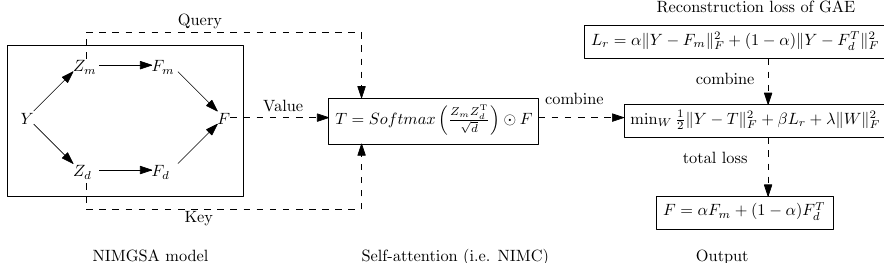
Figure 3. Computation procedure of NIMGSA. NIMC denotes Neural Inductive Matrix